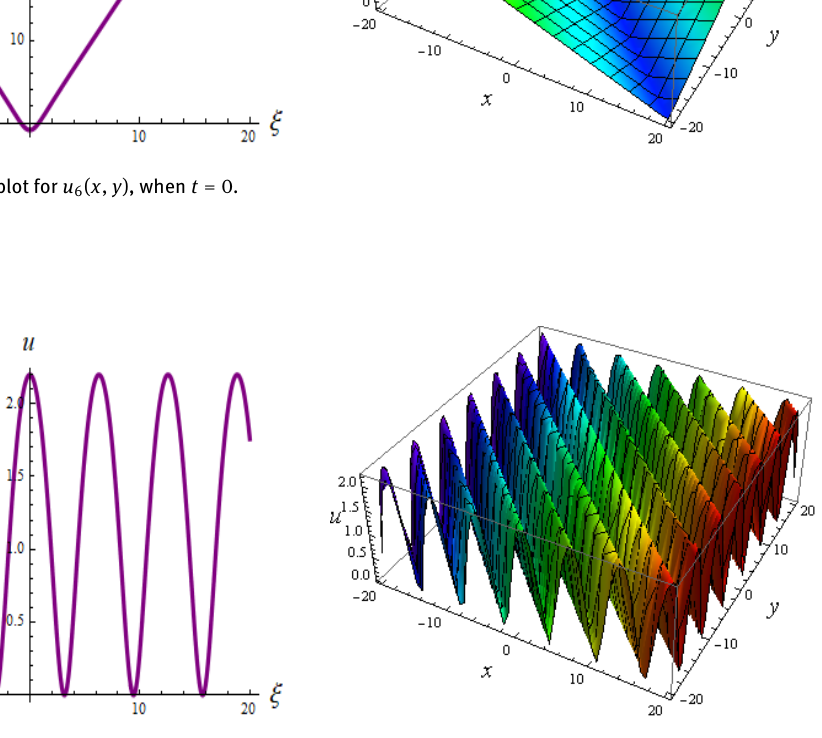
Figure 5: (a) 2D plot for u 10 . (b) 3D plot for u 10 ( x , y ) , when t = 0